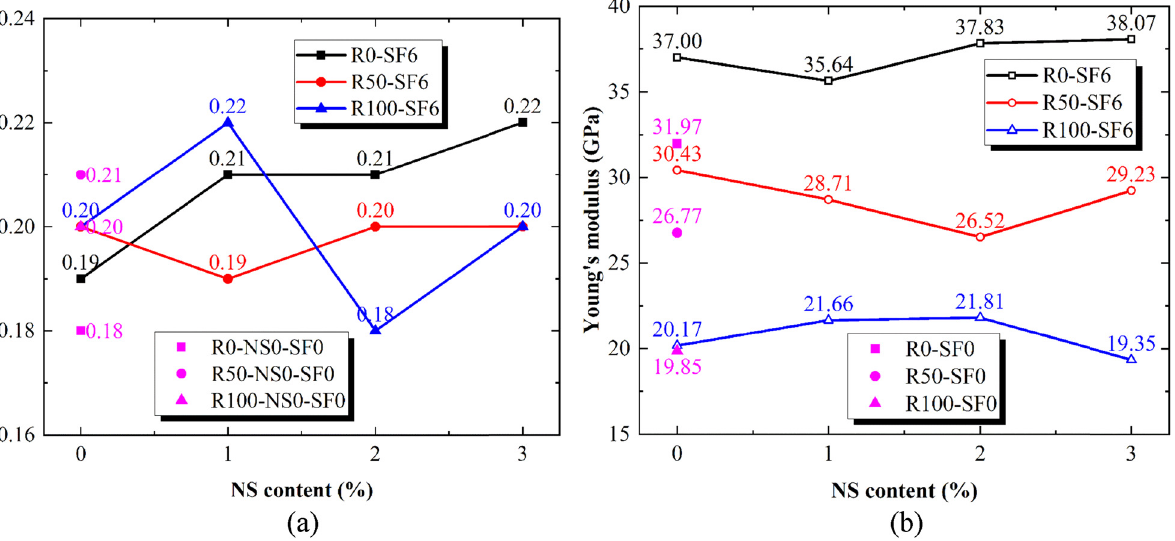
Figure 16: Experimental results of elastic properties: ( a ) Poisson ’ s ratio and ( b ) Young ’ s